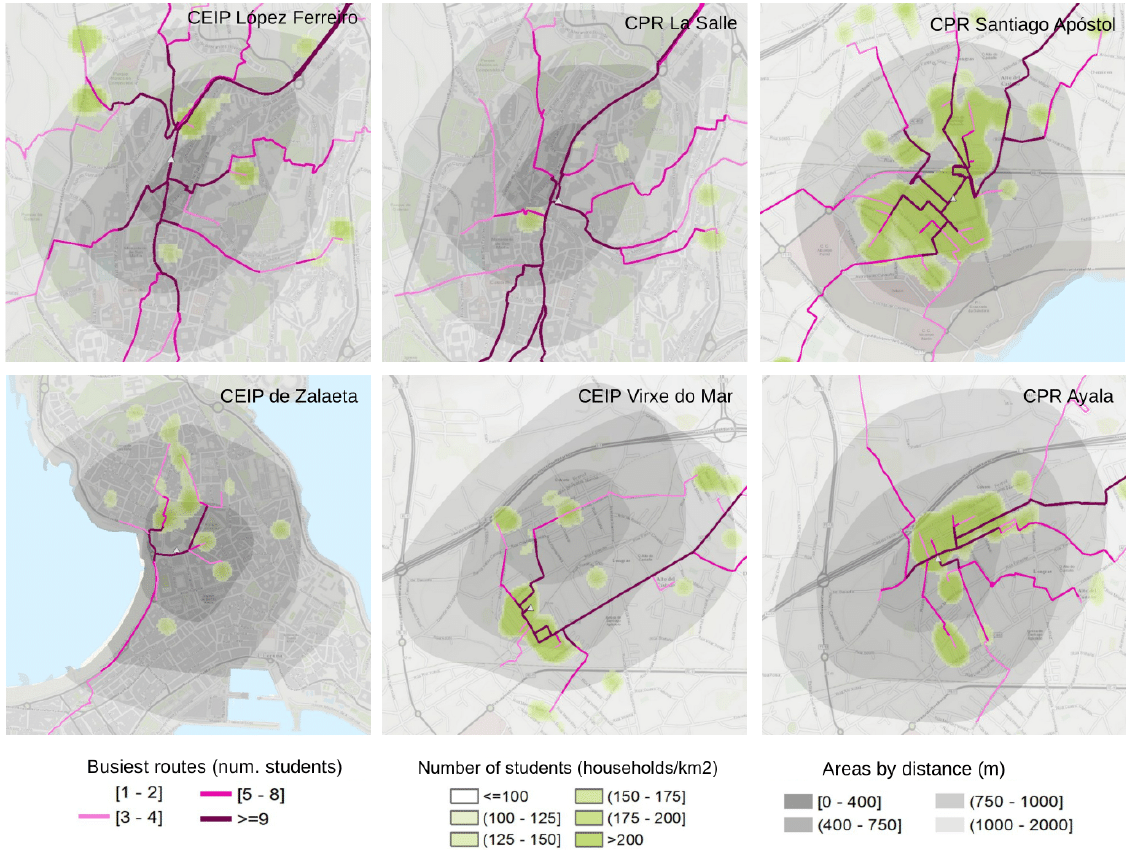
Figure 12. Analysis of optimal routes for an educational